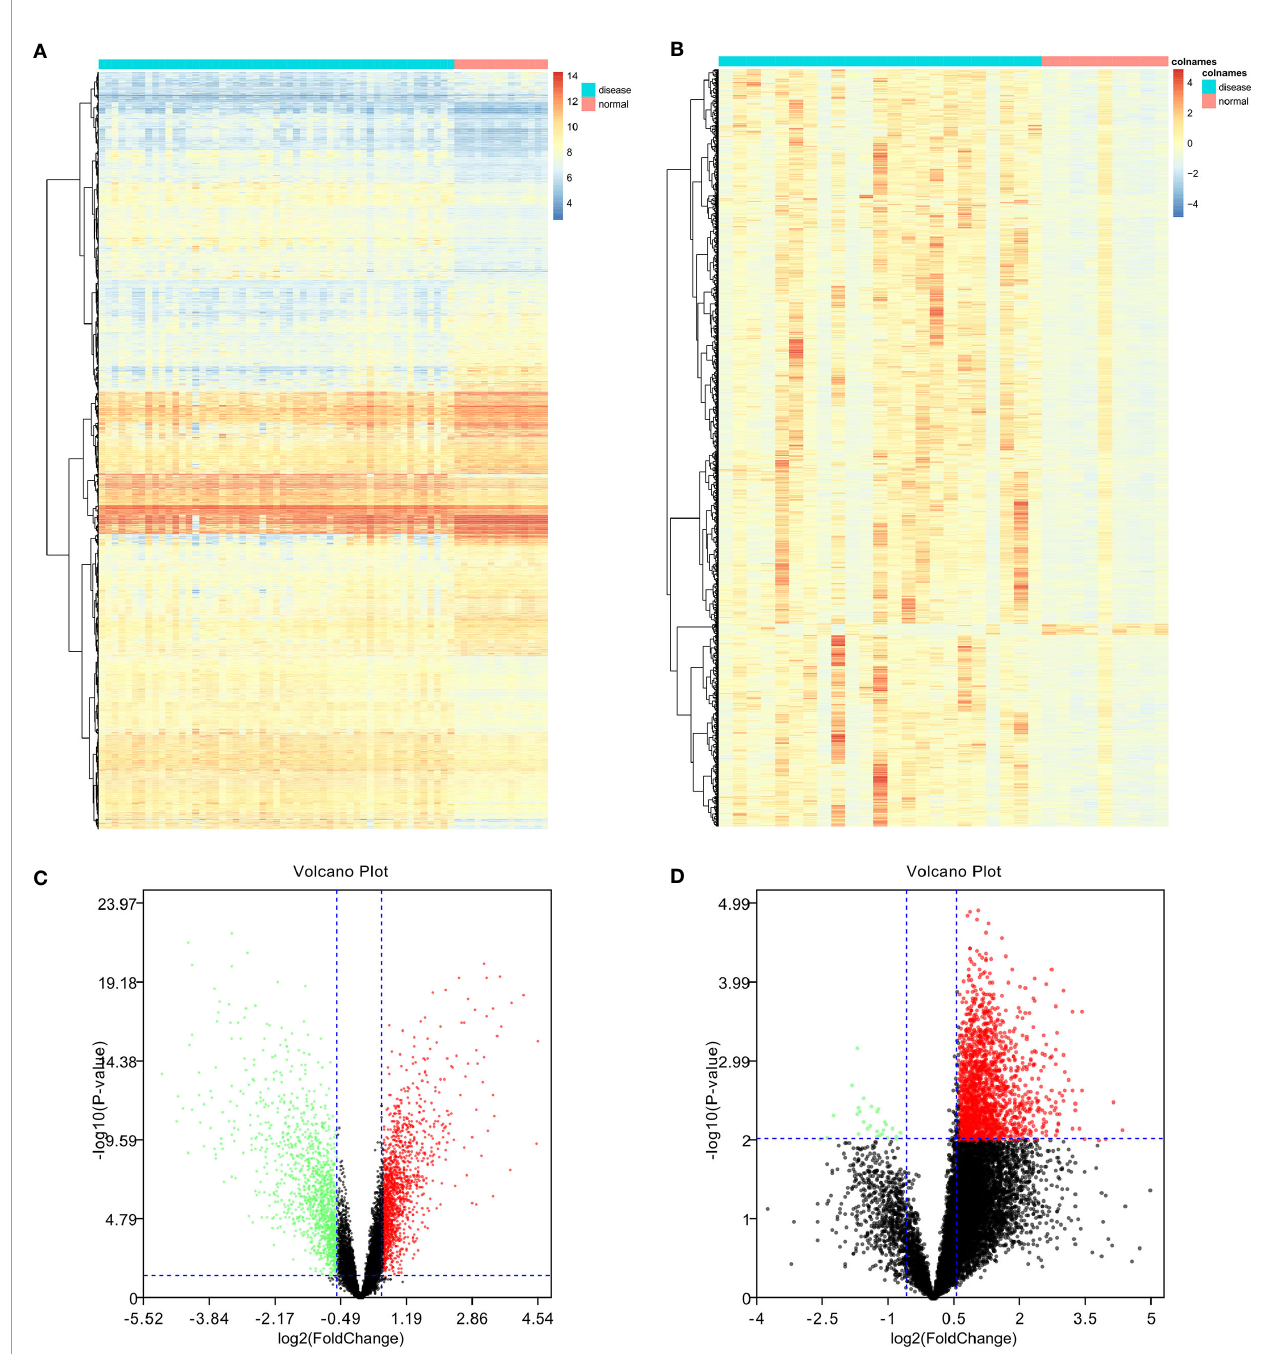
FIGURE 3 | Heat map of differentially expressed genes (DEGs) and volcano plot of genes in the two datasets. Upregulated DEGs are shown in red; downregulated DEGs are shown in green; non-DEGs are shown in black. (A, B) GSE131329 dataset; (C, D) GSE81928